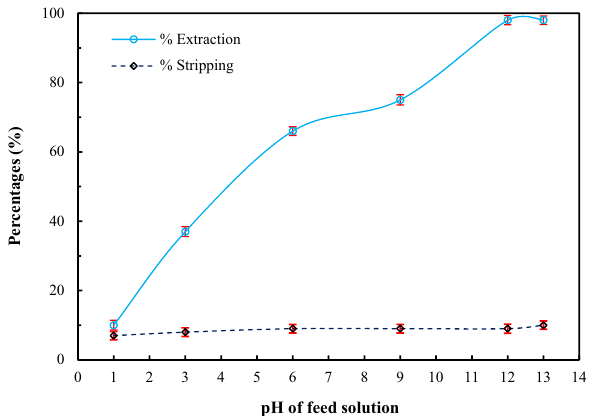
Figure 4. Percentages of extraction and stripping of arsenic ions against pH of feed solution via HFSLM using 0.88 M Aliquat 336 dissolved in toluene as the liquid membrane, having 0.5 M NaOH as the strippant solution, at flow rates of feed and strippant solutions of 100 mL/min; standard deviations for %extraction = ± 1.35 and for %stripping = ± 1.23.